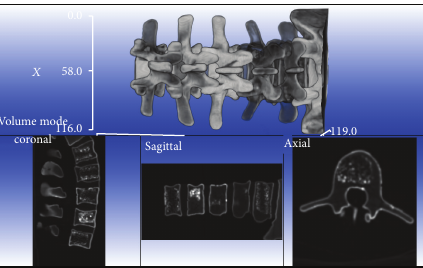
Figure 5: A reconstructed 3D CT spine model with axial, coronal, and sagittal views.